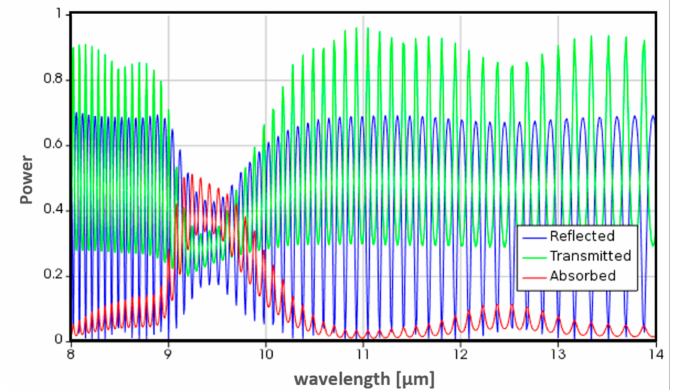
Figure 3. The modeled absorption, reflection, and transmission of the optical window as a function of the wavelength. The silicon wafer size is ~100 µ m and the oxide layer is of the order of 0.1 µ m.